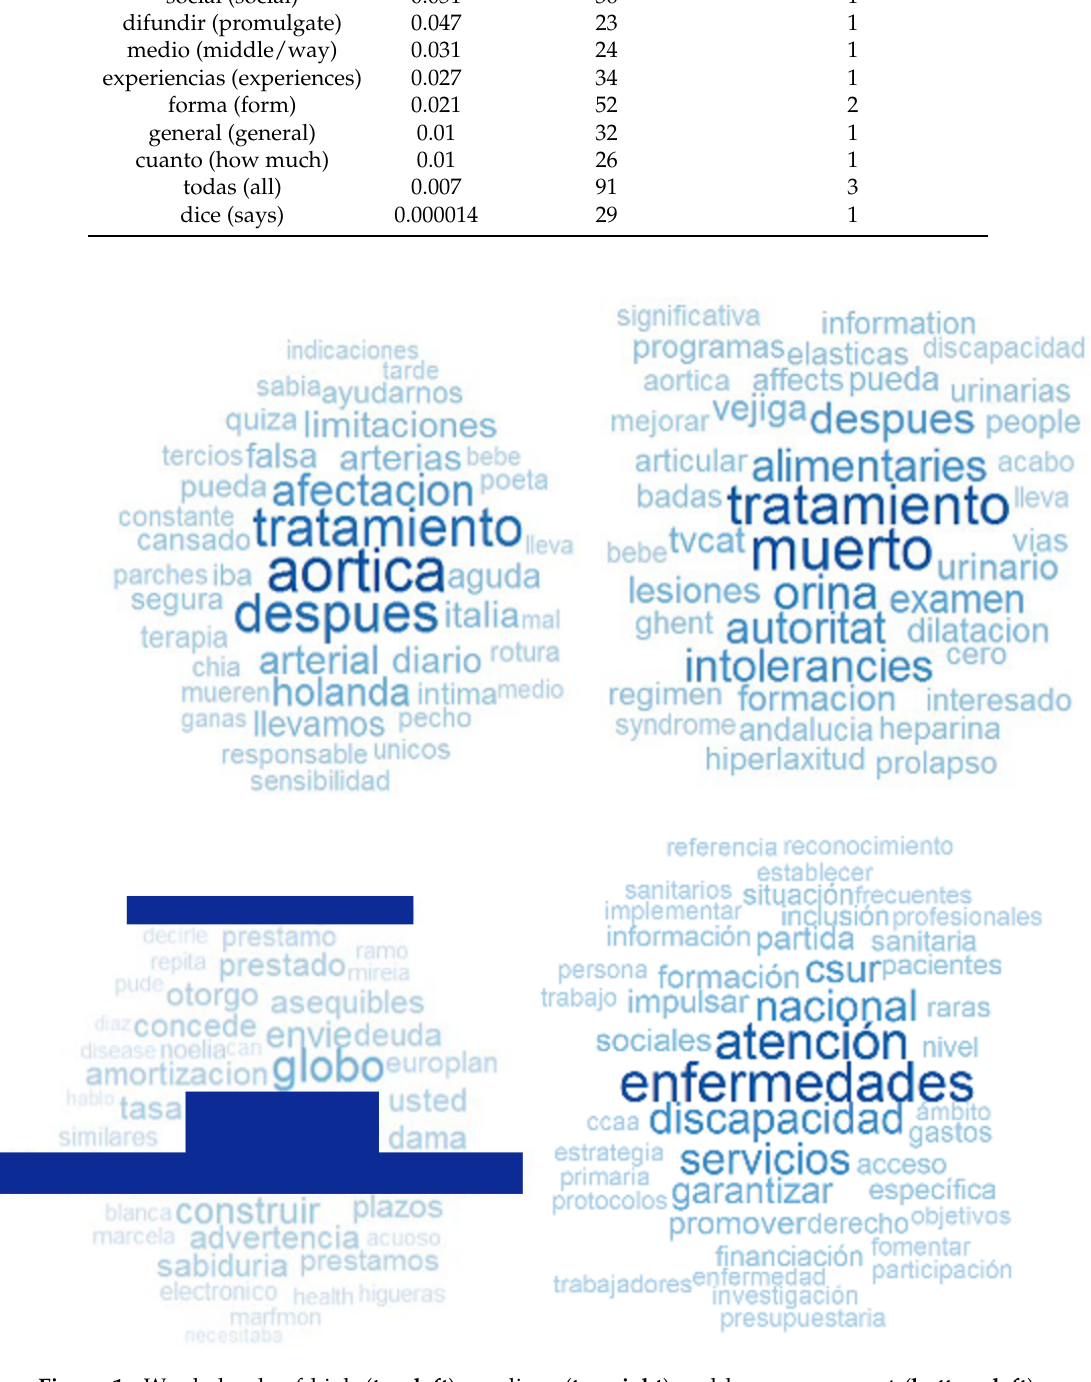
Figure 1. Word clouds of high ( top-left ), medium ( top-right ) and low engagement ( bottom-left ); and decalogue ( bottom-right ). Names and email addresses of the low engagement figure have been removed due to privacy